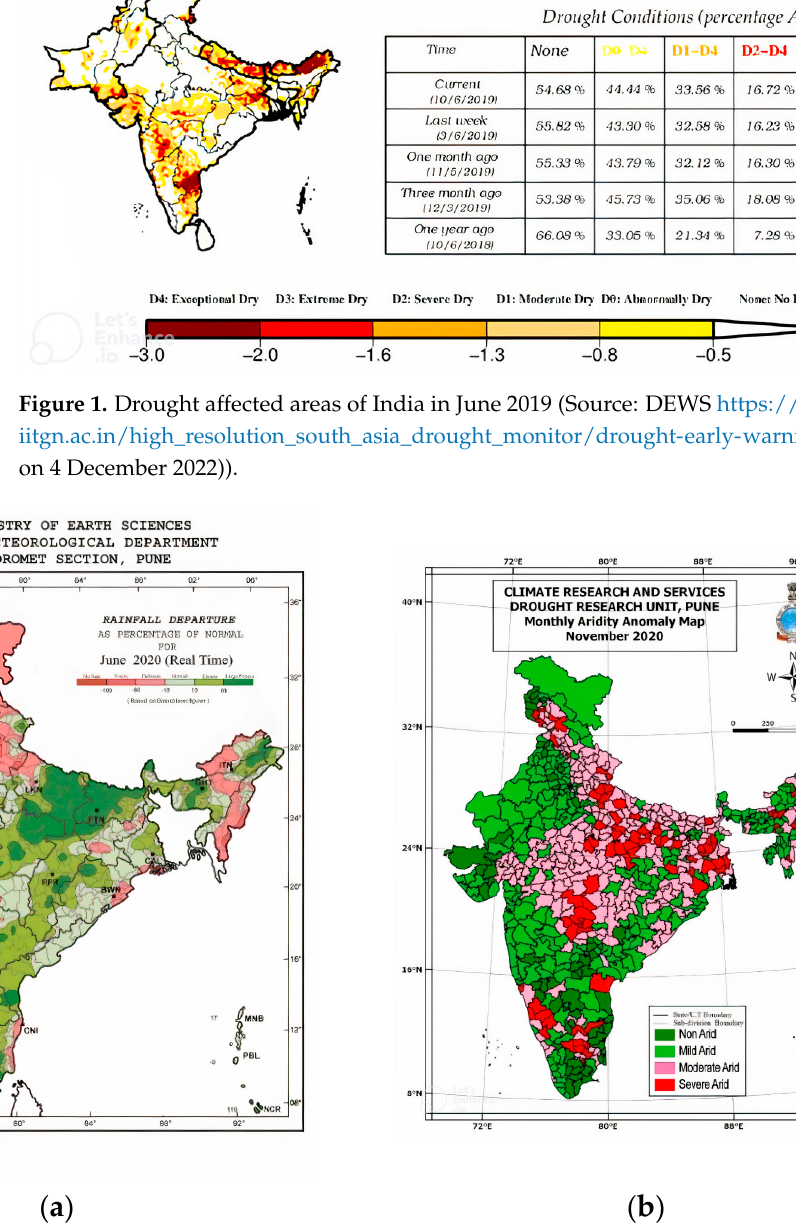
Figure 1. Drought affected areas of India in June 2019 (Source: DEWS https://sites.google.com/a/iitgn.ac.in/high_resolution_south_asia_drought_monitor/drought-early-